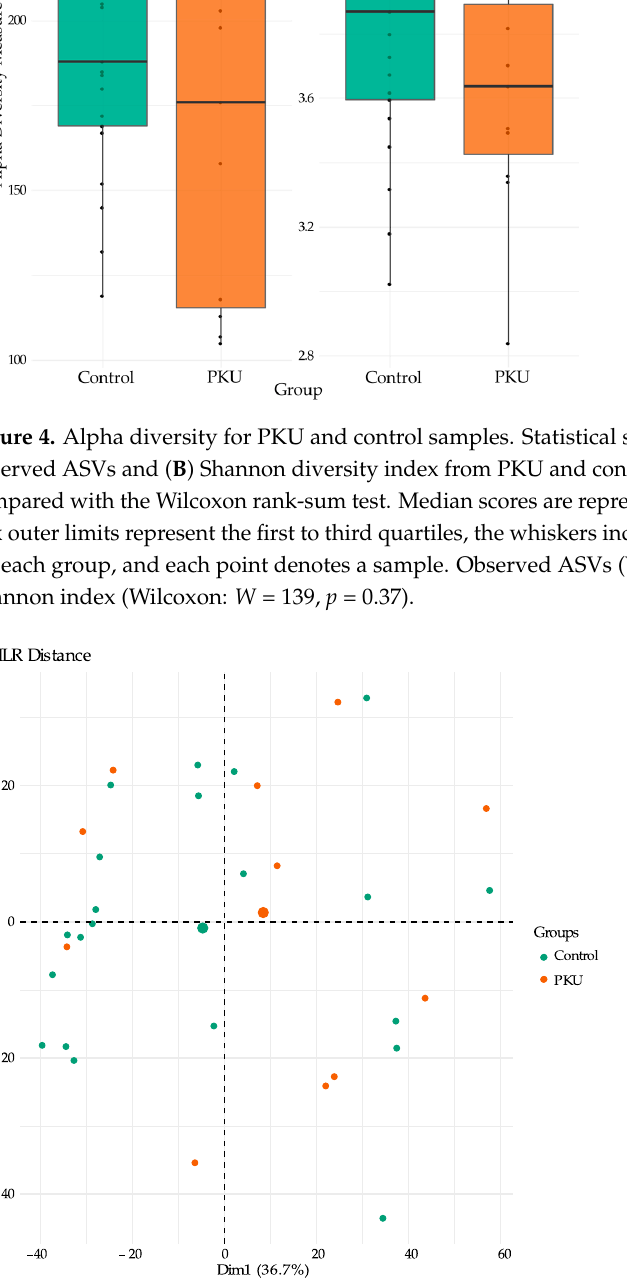
Figure 5. Genus-level beta diversity comparison of the gut microbiota compositions based on principal component analysis (PCA) of PhILR distances for PKU (orange) and control (green) samples. Each point represents a sample, and the condition is denoted by its color; larger circles represent the mean coordinates for each